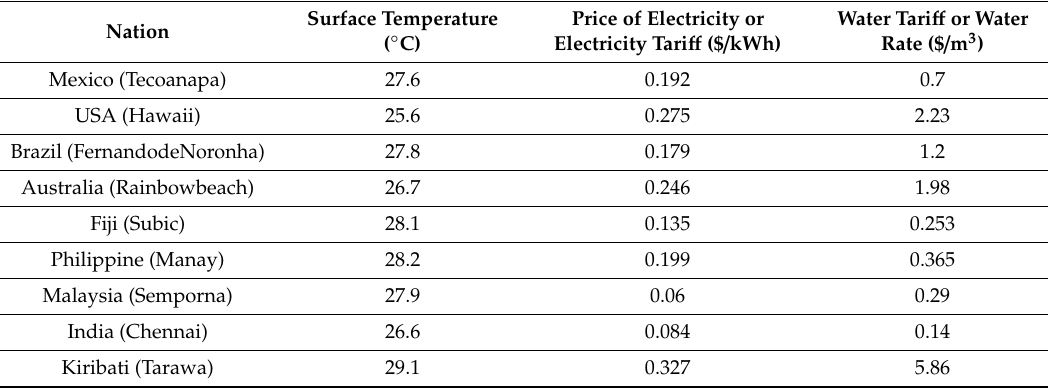
Table 1. Countries expected to apply OTEC system. USA, United States of America.